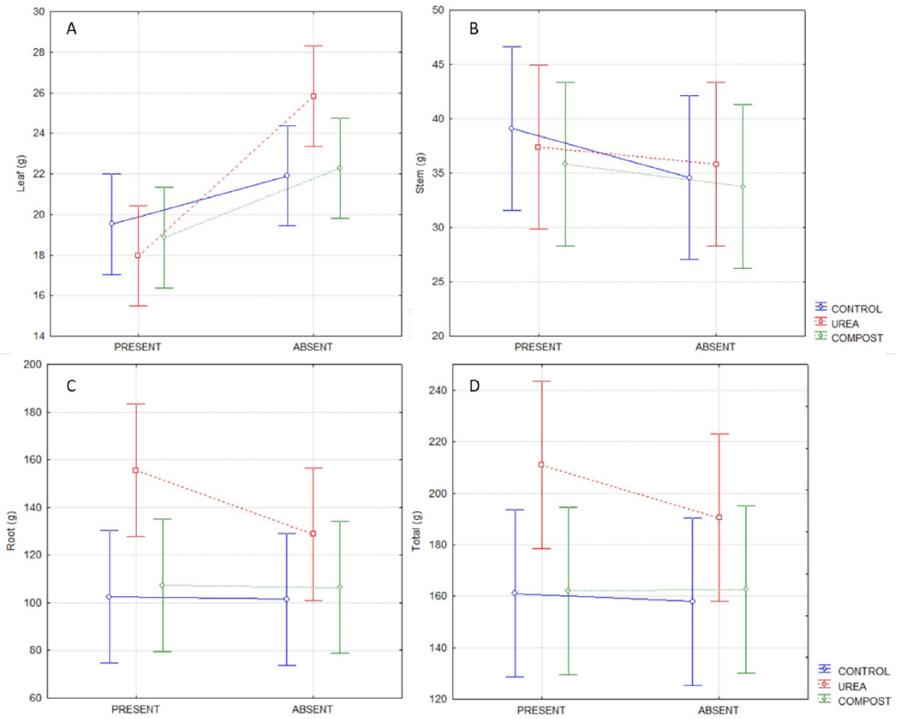
Figure 3. Dry matter of leaves ( A ), stem ( B ), roots ( C ) and total ( D ) of peach trees cultivated with urea and organic compost application, in Paspalum notatum presence and absence. Two-way ANOVA. Tukey test at 5% probability. The values presented are averages of three replicates per treatment and the vertical bar represents the standard